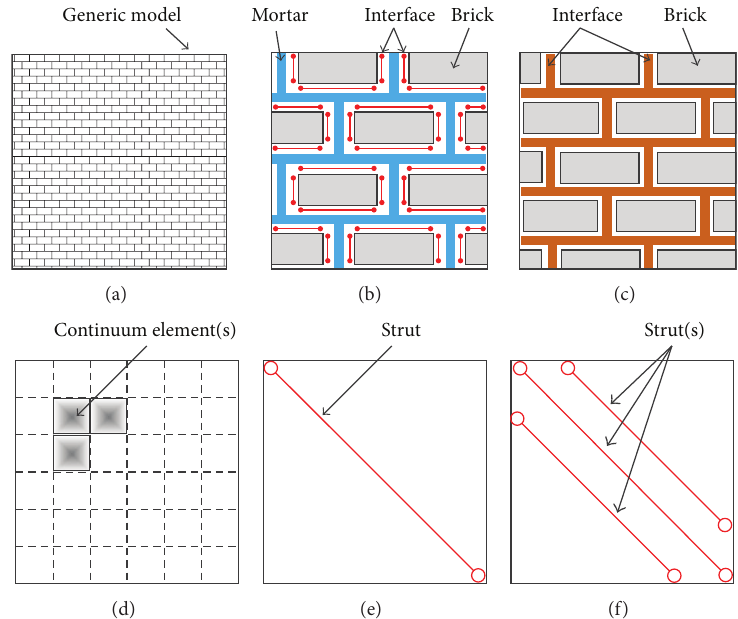
Figure 1: Modeling the masonry infill panels: (a) generic model, (b) micromodeling, (c) mesomodeling, (d) homogenized macromodeling, (e) single-strut macromodeling, and (f) multistrut macromodeling.